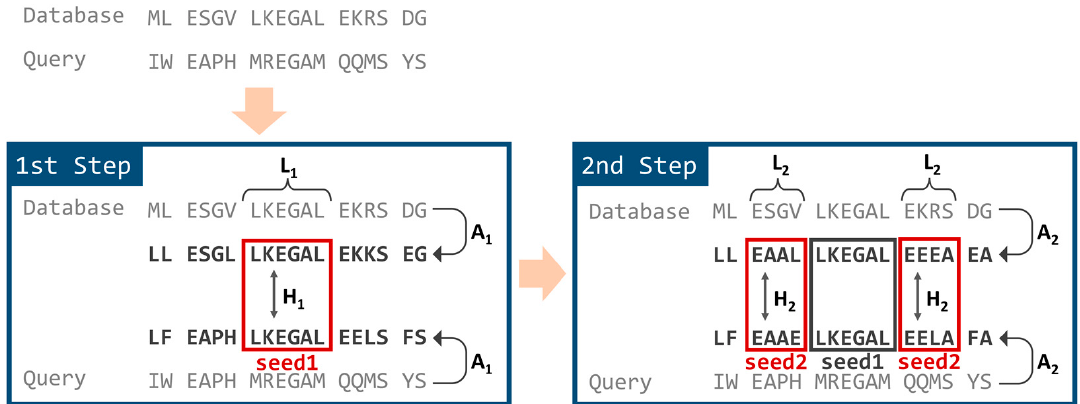
Figure 2. Seed search steps of TSSS. Figure 2.